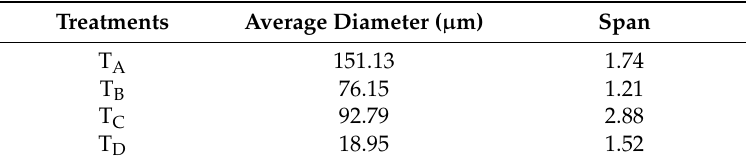
Table 2. Average diameter and particle size distribution (Span) of the PHF extract microencapsulated with GA, GE, MD and their combinations by freeze-drying